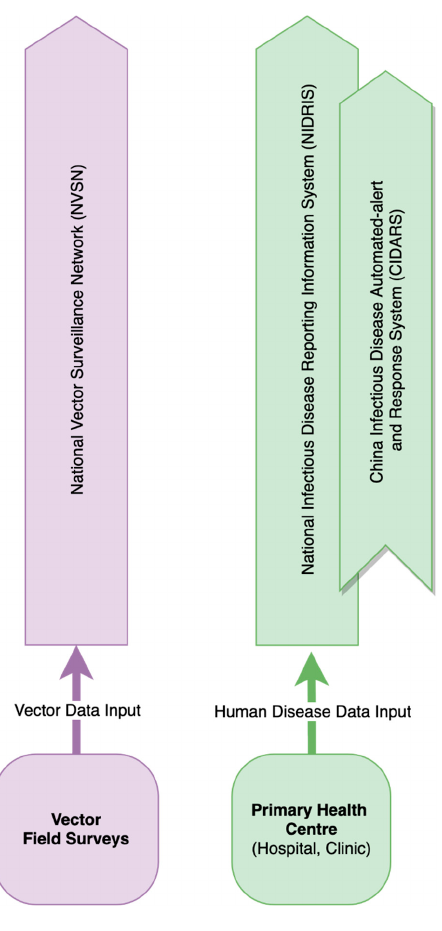
Figure 3. Representation of web-based reporting networks developed by China CDC. Purple represents vector web-reporting structures. Green represents human disease case web-reporting structures. CIDARS using data from NIDRIS acts as a real-time alert system using SMS to notify authorities of abnormal data signals. Health authorities at all governance levels are able to review the data to support response actions. This representation was based on qualitative data from experts from Beijing.